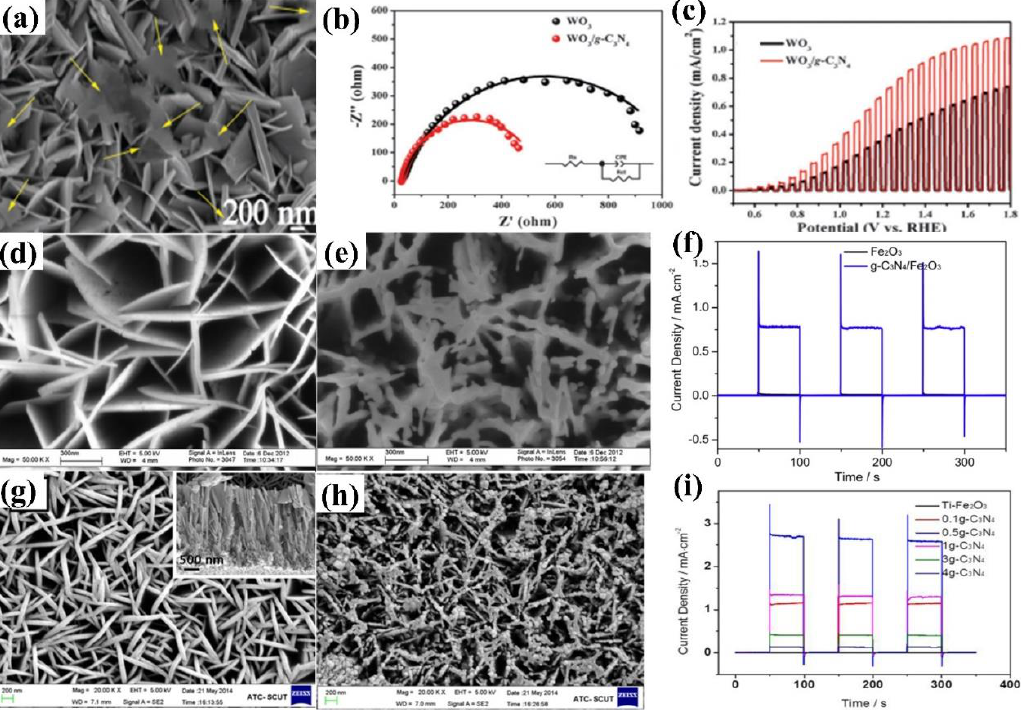
Figure 20. ( a ) SEM image of WO 3 / g−CN NSAs. ( b ) Electrochemical impedance spectra. ( c ) I – V curves measured at a scan rate of 5 mV s −1 . Reprinted with permission from ref. [195] Copyright 2016 American Chemical Society. Top-view SEM images of ( d ) Fe 2 O 3 , ( e ) g−CN /Fe 2 O 3 . ( f ) I-t curves in 1.0 M NaOH at 0.23 V vs. Ag/AgCl. Reprinted with permission from ref. [197] Copyright 2014 Elsevier. Top-view SEM images of ( g ) Ti−Fe 2 O 3 , ( h ) 0.5g−CN/Ti−Fe 2 O 3 (the inset is the cross-section of Ti−Fe 2 O 3 ). ( i ) I-t curves in 1.0 M NaOH at 0.23 V vs. Ag/AgCl. Reprinted with permission from ref. [199] Copyright 2016 Elsevier.